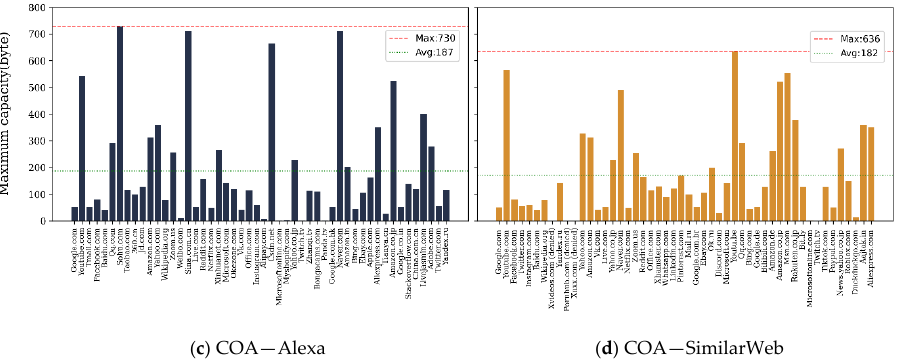
Figure 11. The capacity of Changing the Case of Letters (CCL) in tags and attributes and Changing the Order of Attributes (COA) from each website list.